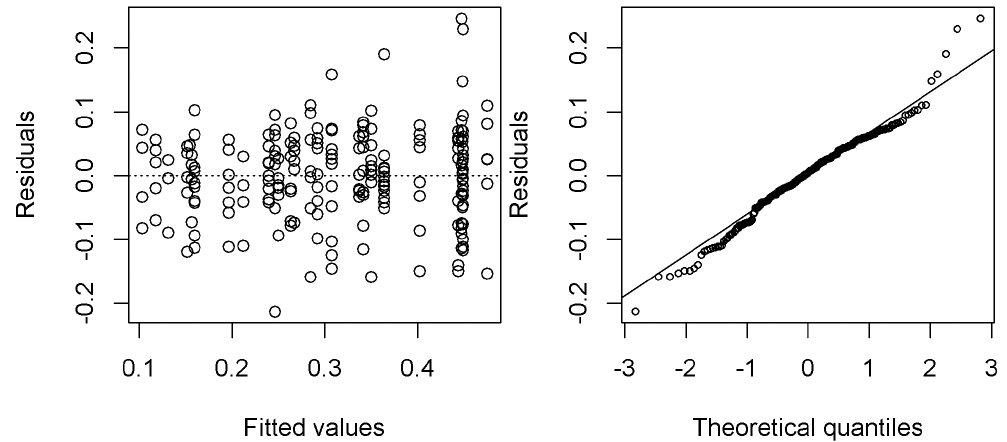
Figure A3. Residuals of the linear model used to model seedlings relative growth rate in diameter. The analysis of models’ residuals showed that conditions for normality, homoscedasticity, and independency between observations were correctly met. All observations had Cook’s distances <1 indicating that no outliers influenced coefficient estimates.